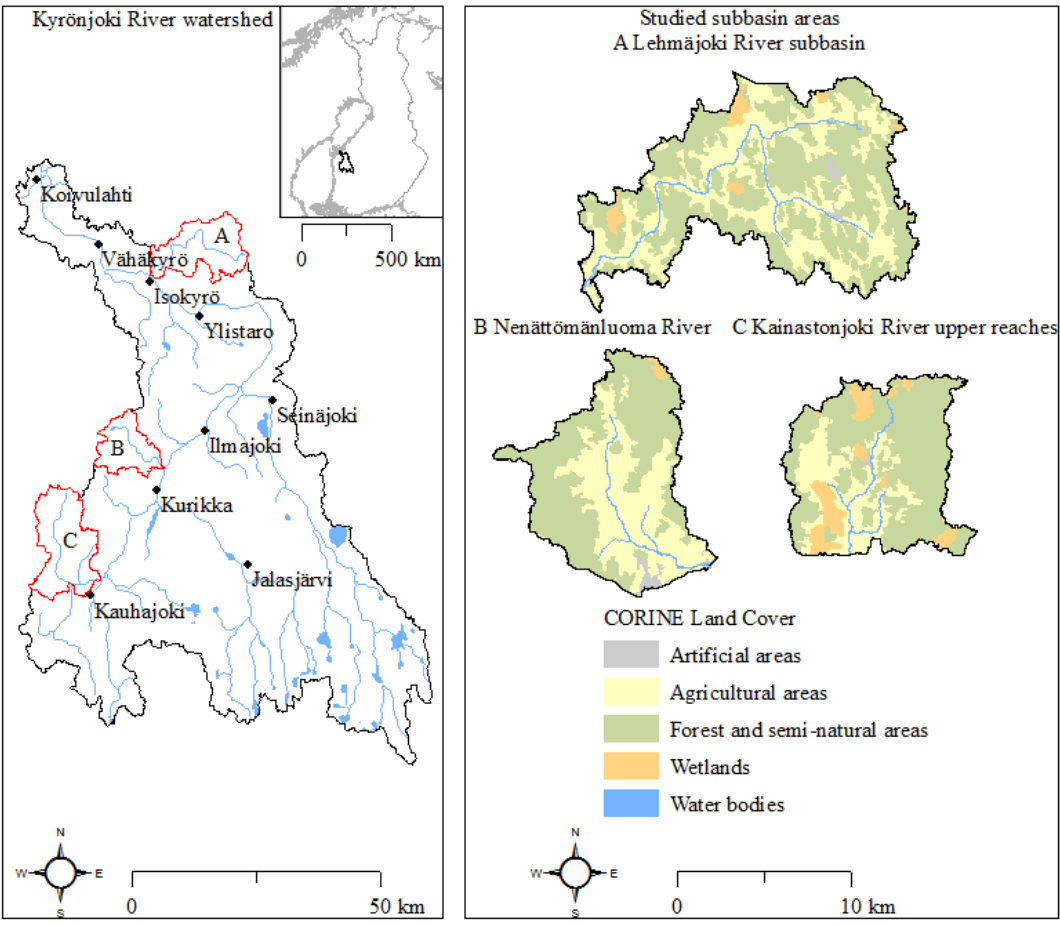
Figure 3. The watershed of Kyrönjoki River and the SBAs